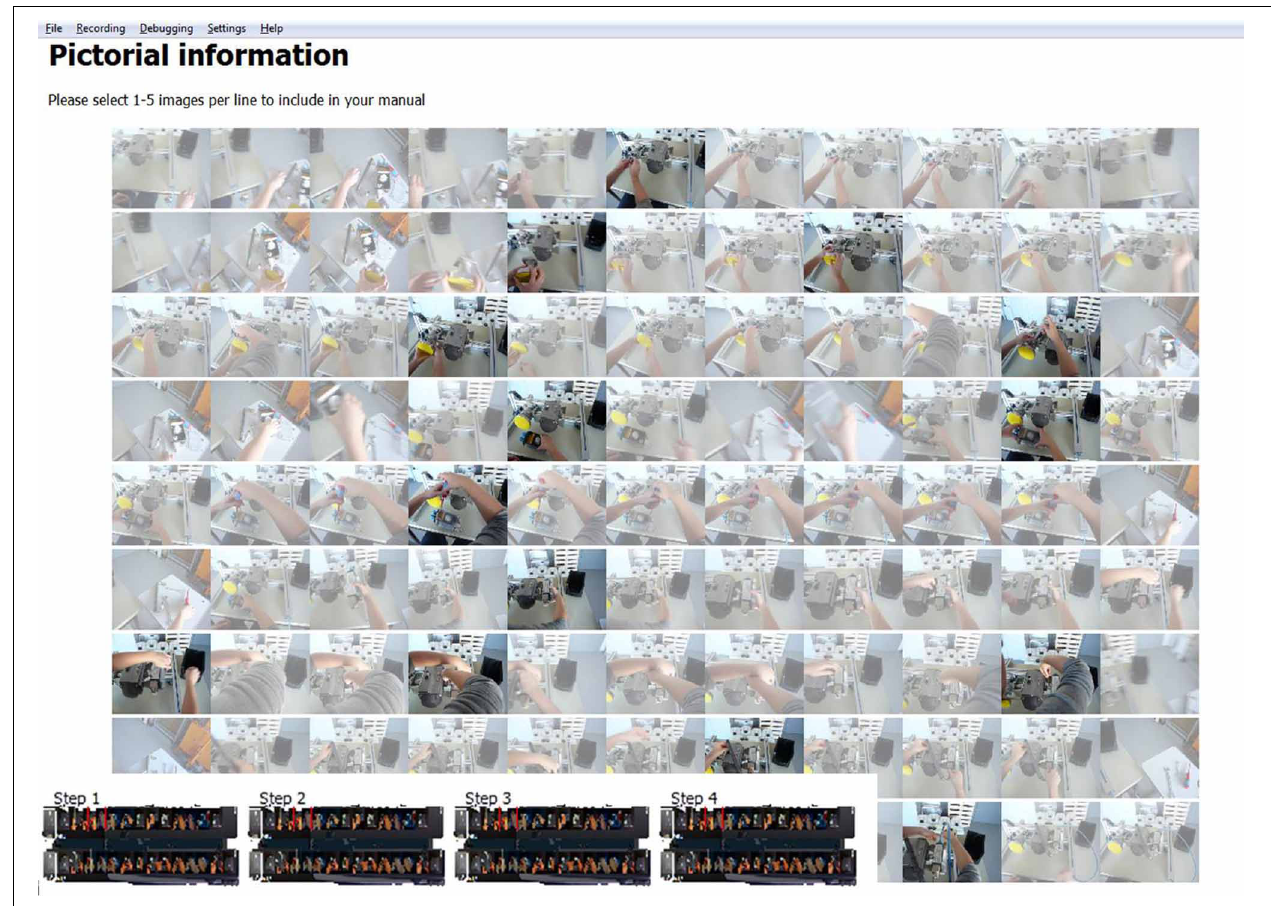
FIGURE 2 | Screenshot for step 2 within the IBES tool where users choose appropriate pictures representing each instructional step. Pictures that have been chosen for the manual are shown more clearly than the